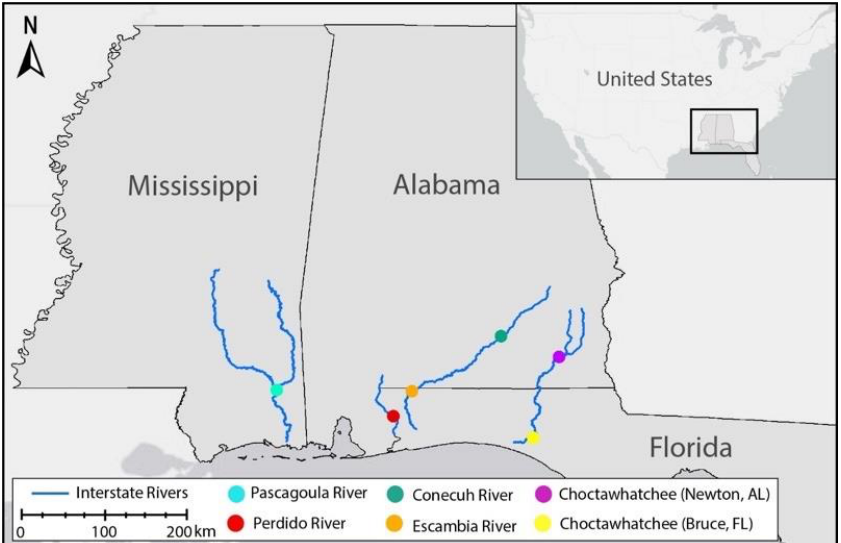
Figure 1. Location map with inset of study location within the overall United States (small black rectangle) and the six United States Geological Survey (USGS) streamflow gages used within the study between the states of Mississippi, Ala- bama and Florida.